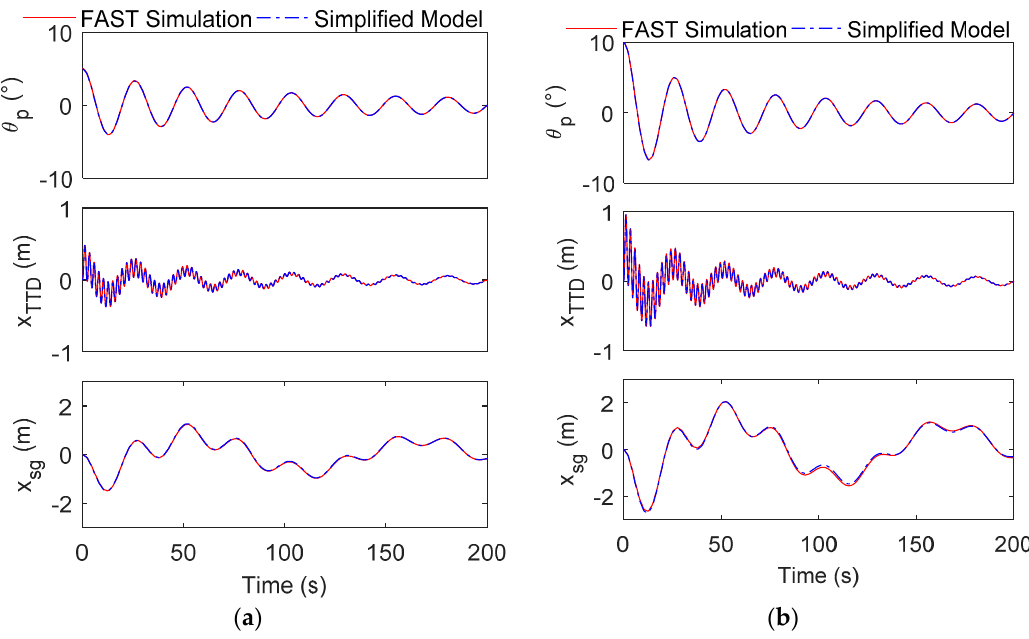
Figure 4. Comparison of responses between the simplified model and FAST simulation with inactive tuned mass damper (TMD): ( a ) 5° initial platform pitch; and ( b ) 10° initial platform pitch.